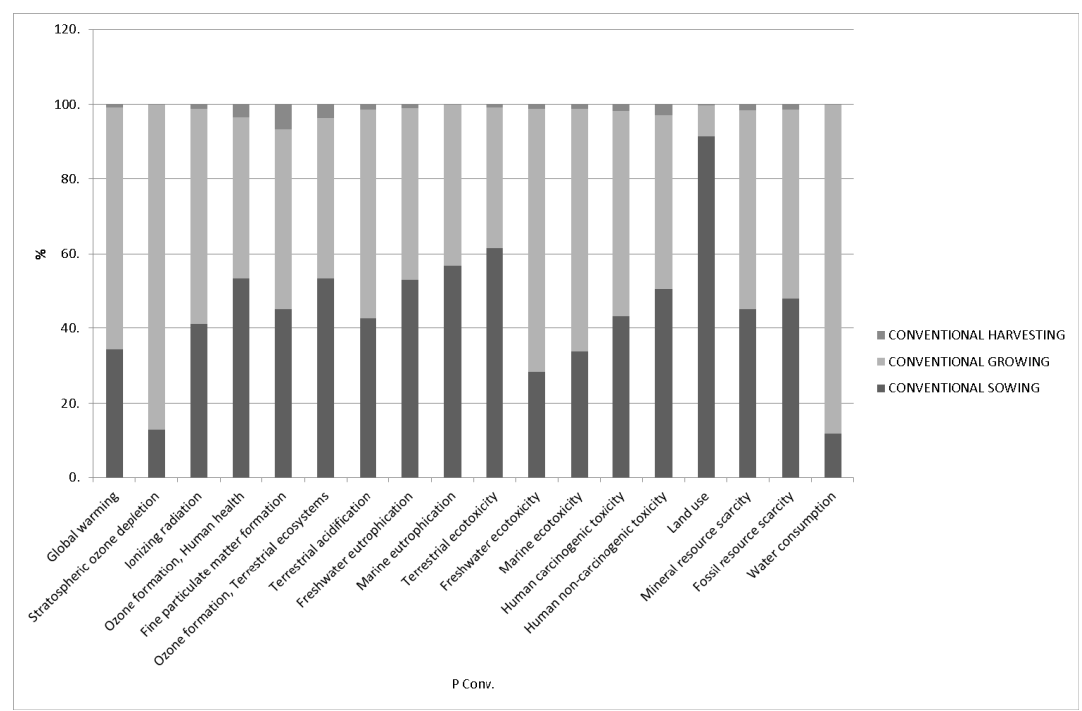
Figure 4. Environmental impact of early potato cultivation with conventional method, per impact category and main cultivation operations.